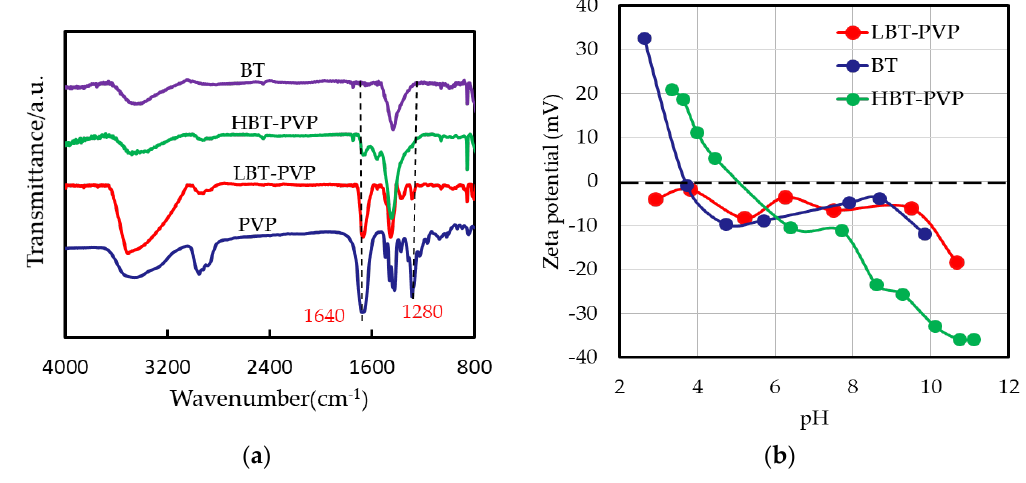
Figure 2. ( a ) FT-IR spectra of BT, HBT-PVP LBT-PVP and PVP; ( b ) relationship of zeta potential and pH of BT, LBT-PVP, and HBT-PVP in H 2 O.